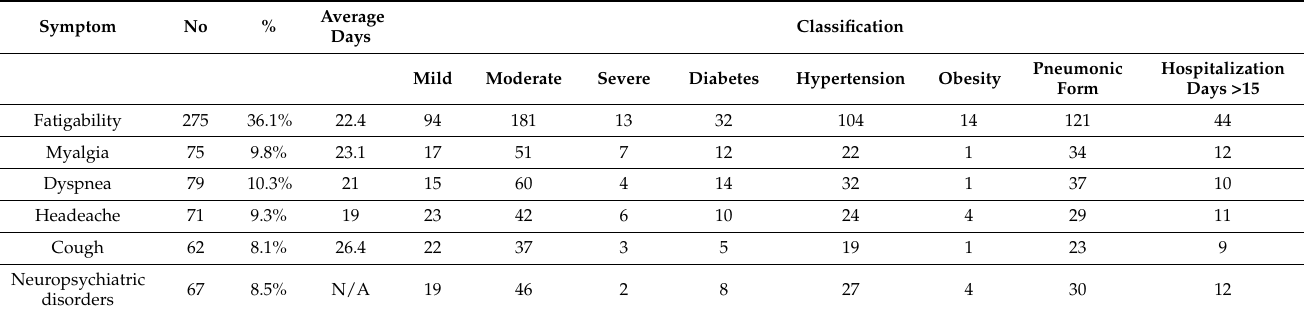
Table 2. Persistent symptoms after SARS-CoV-2 infection in relation to associated comorbidities, the form of disease experienced, and days of hospitalization Table 1. Pearson’s r correlation coefficient according to age and hospitalization duration. Pearson r (Based on Age and Days of Hospitalization)